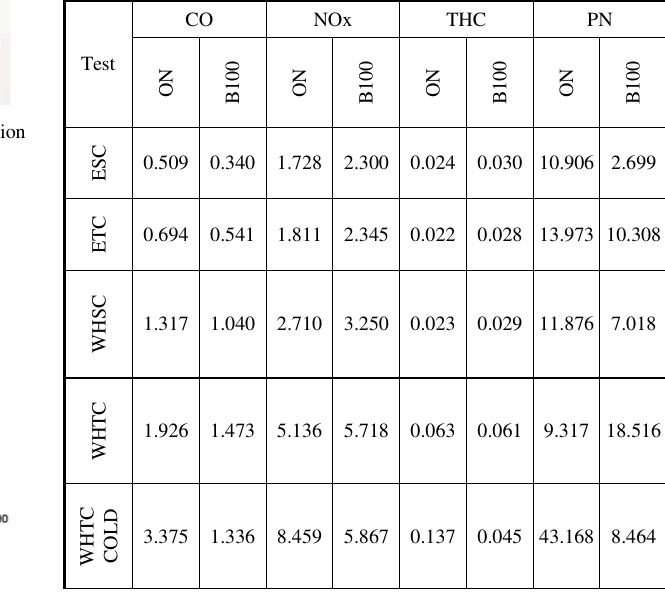
Table 4. Emission test results in different cycles